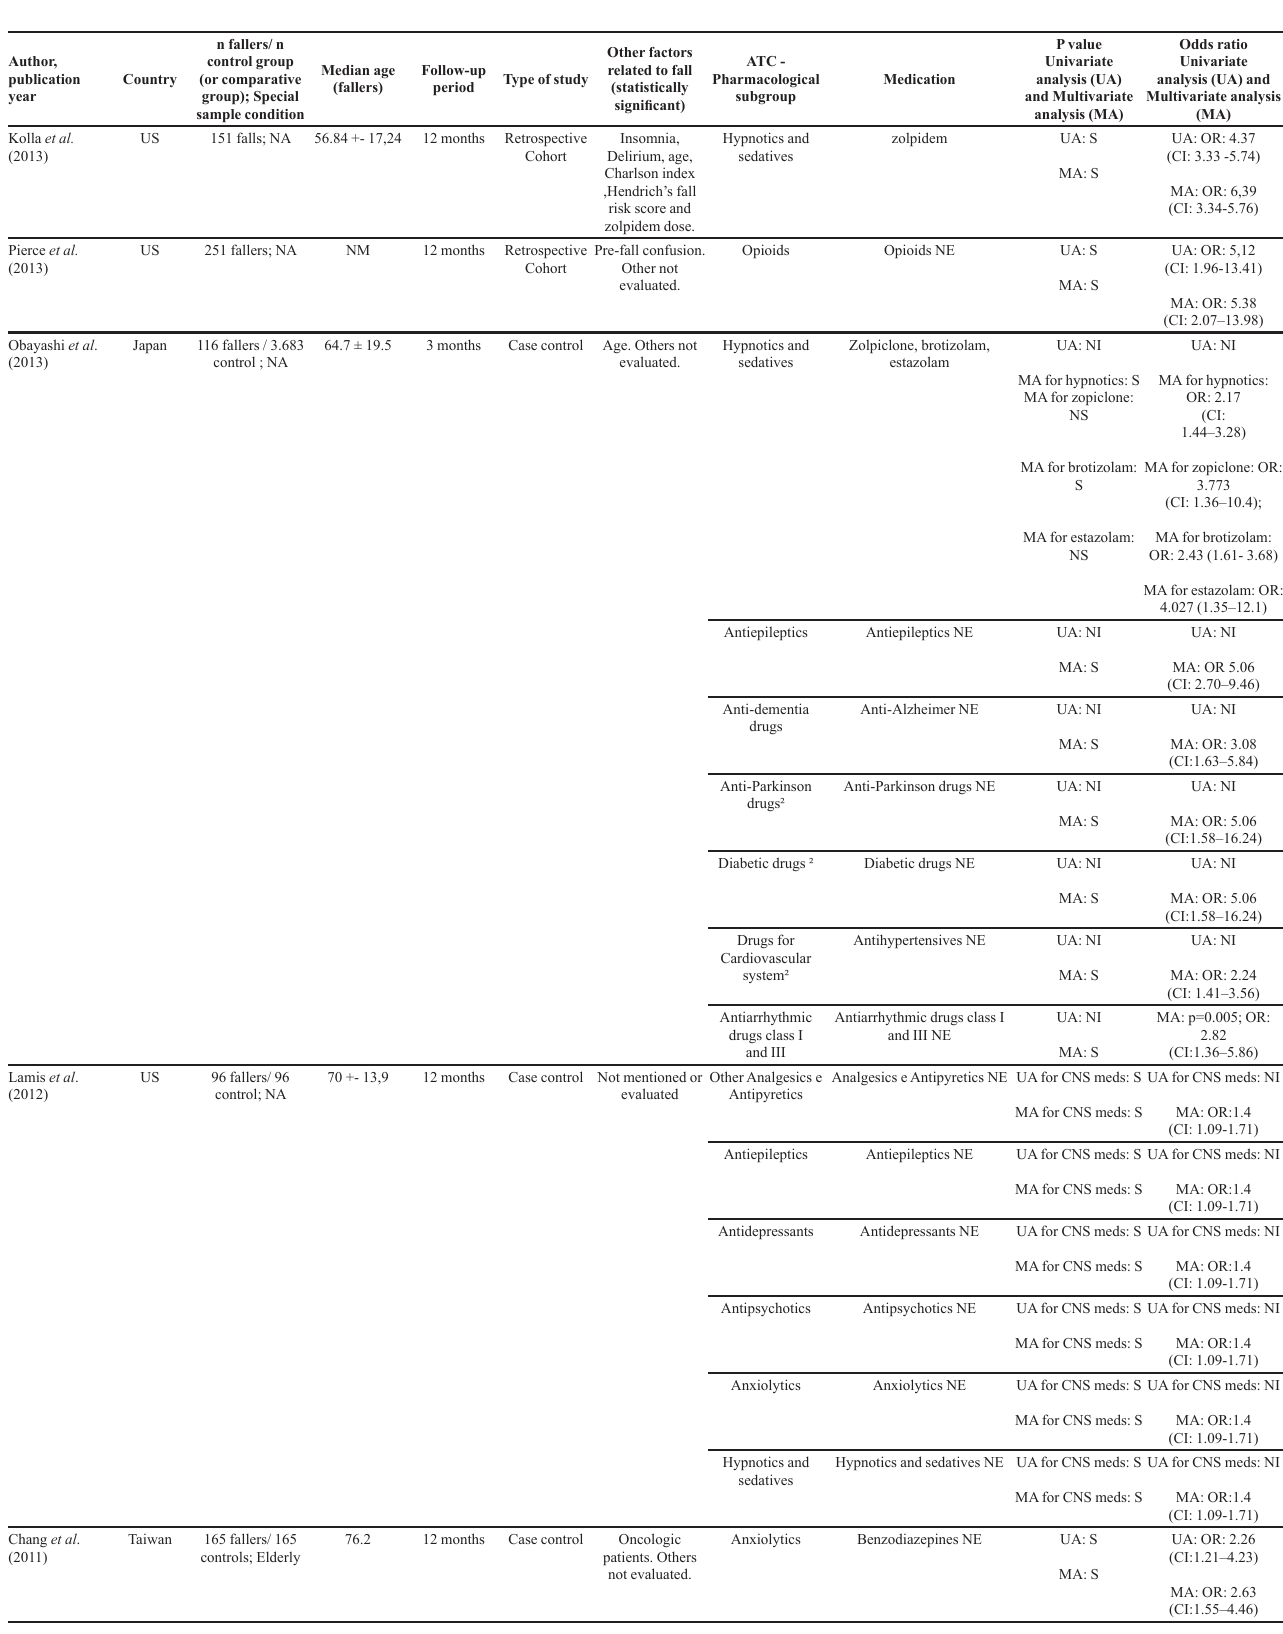
TABLE III - Eligible studies data